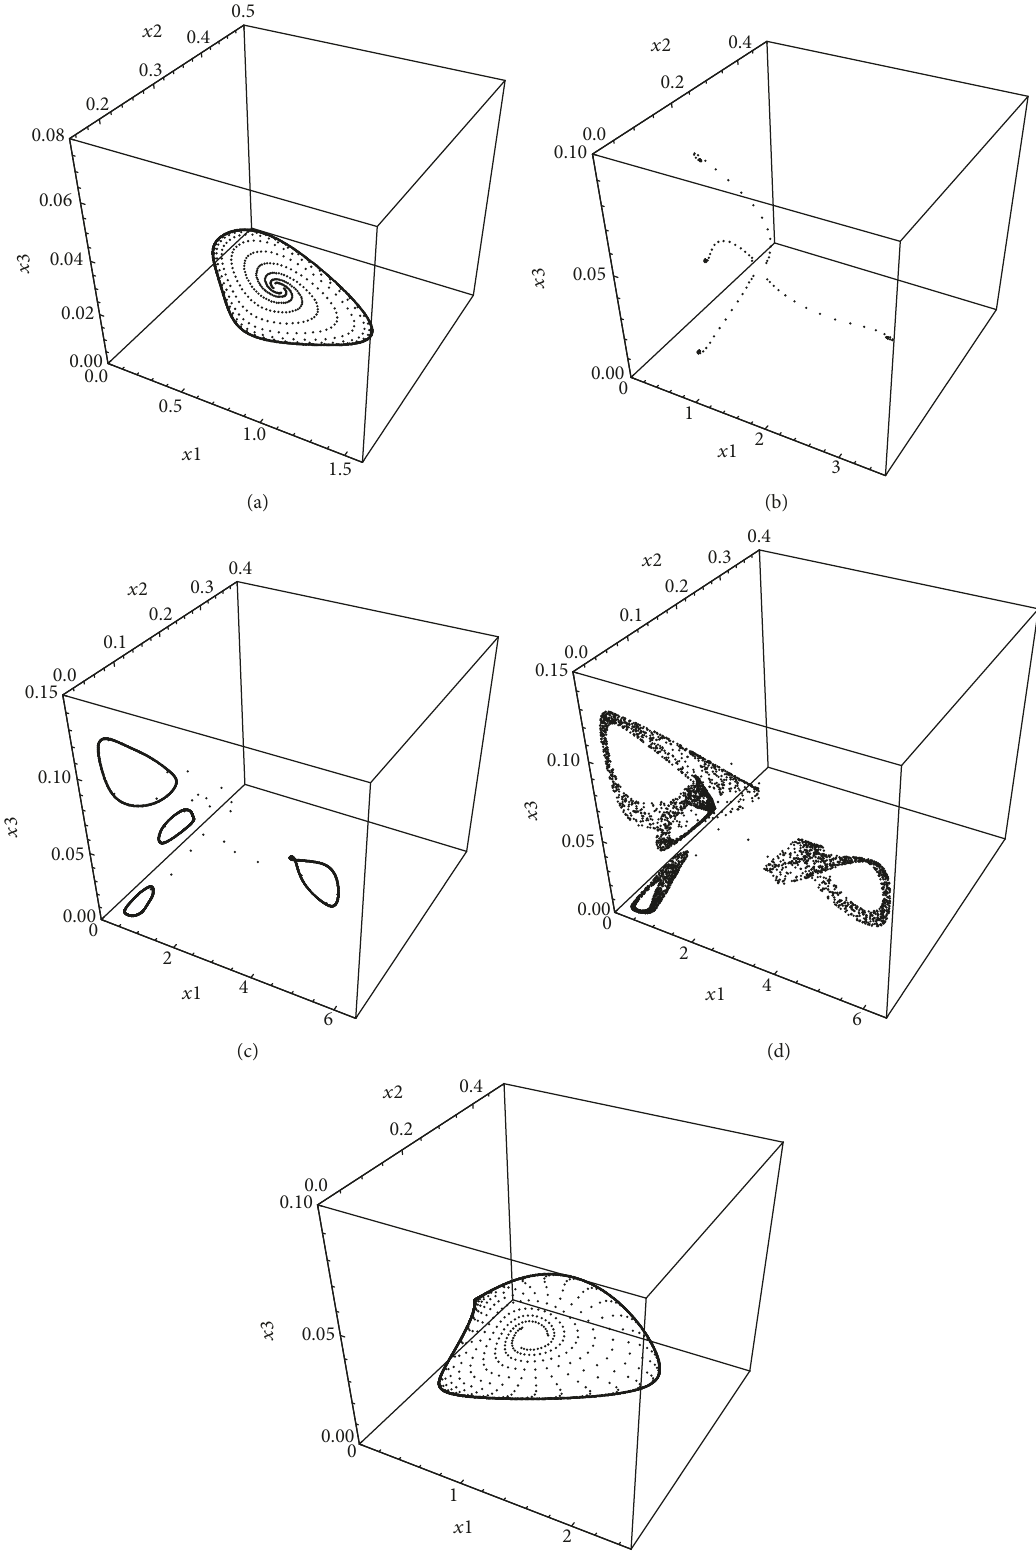
Figure 5: (a) A quasiperiodic orbit which settles on an invariant curve. (𝛼,𝛽) = (0, 1) and (𝑃,𝐹) = (0.7, 24) . (b) Convergence towards a 4-cycle. (𝛼,𝛽) = (0,1) and (𝑃, 𝐹) = (0.7, 30) . (c) 4 invariant curves which are visited once every fourth iteration. (𝛼,𝛽) = (0,1) and (𝑃,𝐹) = (0.7, 39) . (d) Chaotic dynamics. (𝛼,𝛽) = (0,1) and (𝑃,𝐹) = (0.7, 43) . (e) Dynamics in the case (𝛼,𝛽) = (0.9, 1) and (𝑃,𝐹) = (0.7, 95)